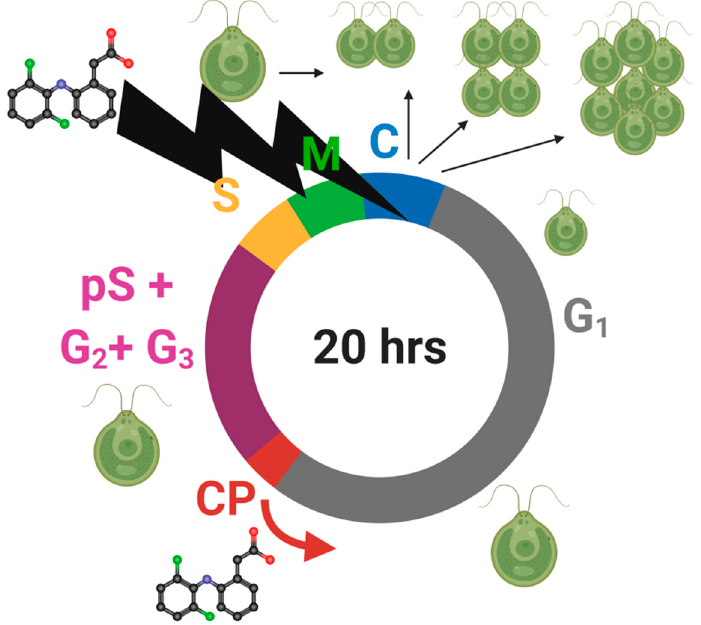
Figure 6. Illustration of the DCF influence on Chlamydomonas reinhardtii cell cycle (scheme of cell cycle by Zachleder et al. [48], modified) .